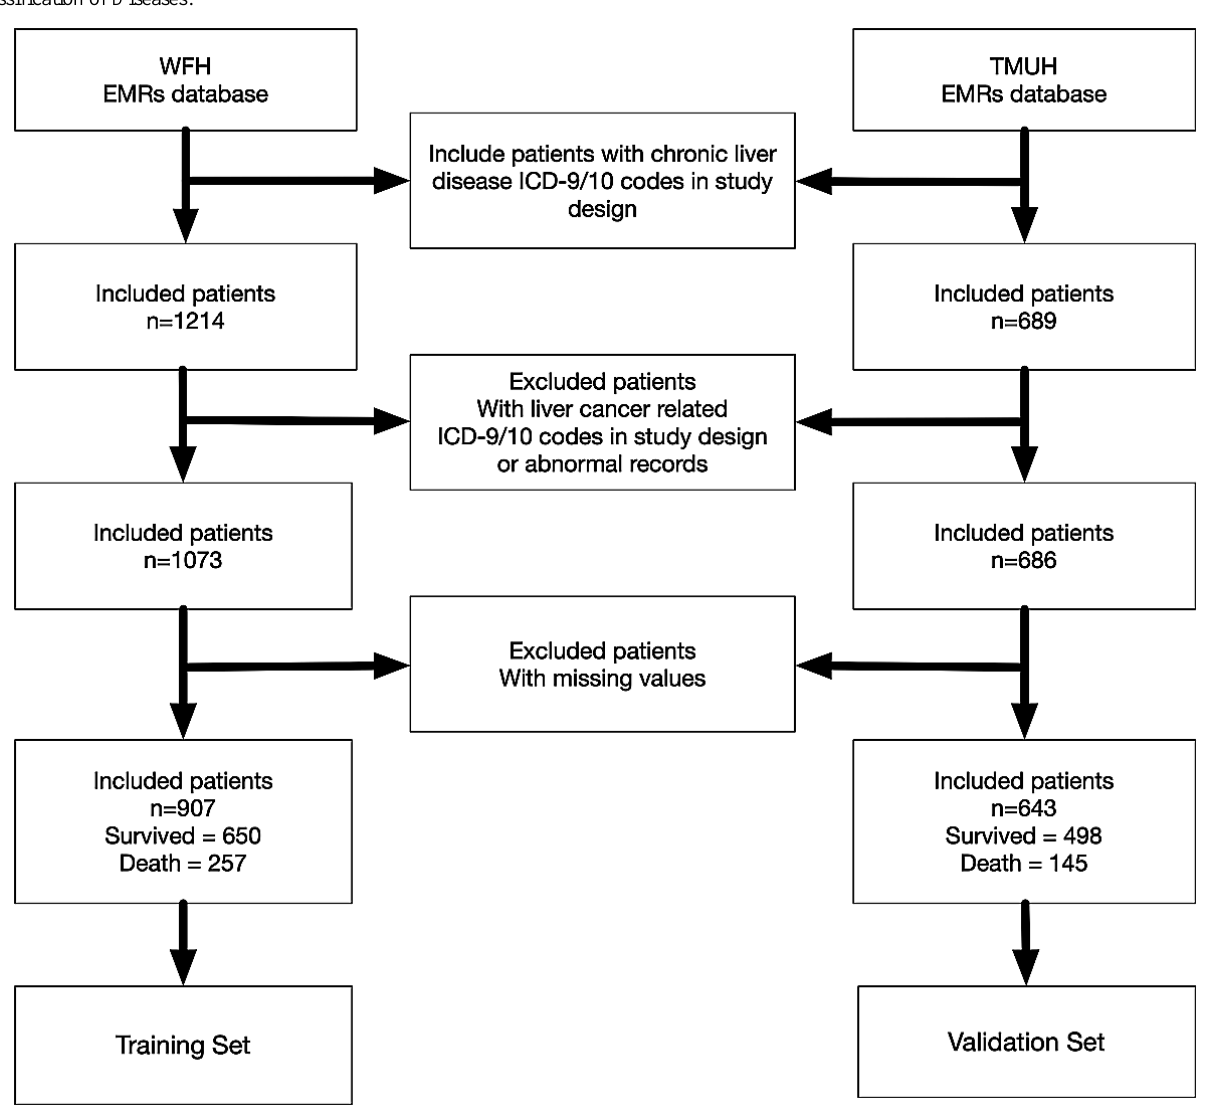
Figure 1. Study flowchart depicting the series of procedures from enrollment to outcome for data collection from patients with noncancer-related end-stage liver disease. WFH: Wan Fang Hospital; TMUH: Taipei Medical University Hospital; EMR: electronic medical record; ICD: International Classification of